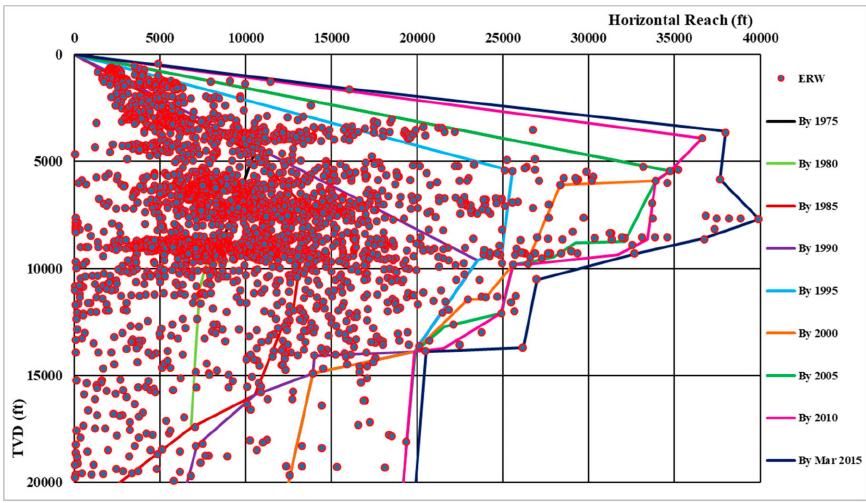
Figure 1. Worldwide ERD Database Update on March 2015 [4].